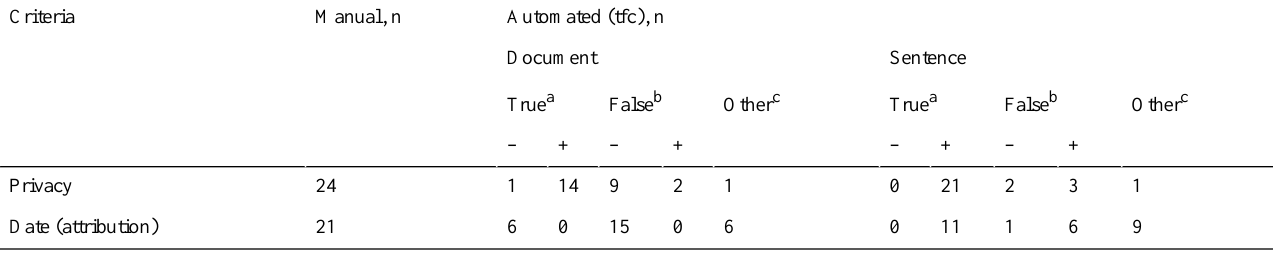
Table 3. Privacy and date criteria using sentences versus the whole document approach (N=27).